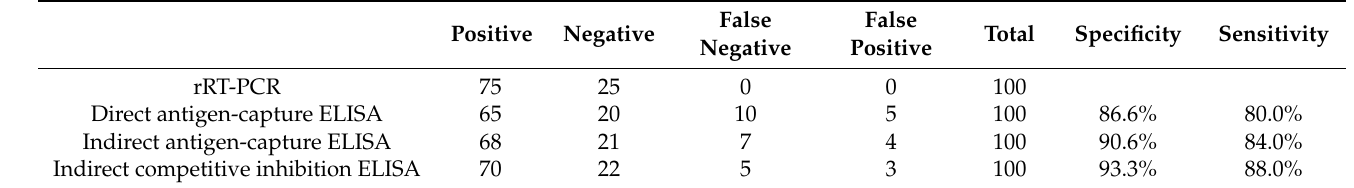
Table 1. Comparison of the results obtained with developed ELISA kits and PCR for human orthop- neumovirus F protein